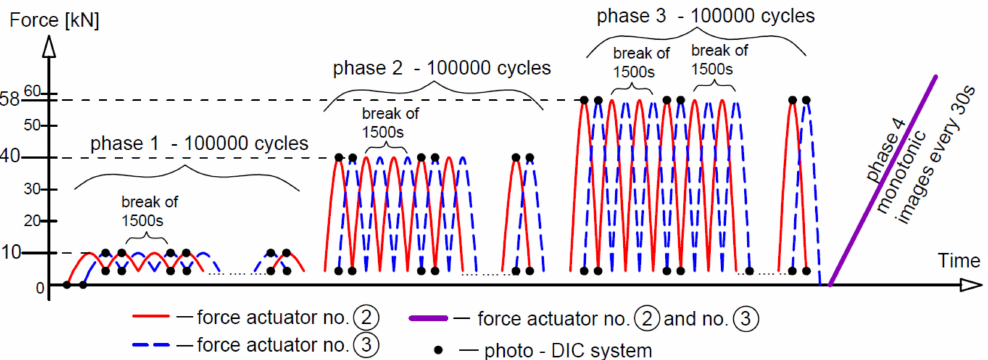
Figure 20. Digital imaging scheme for beams